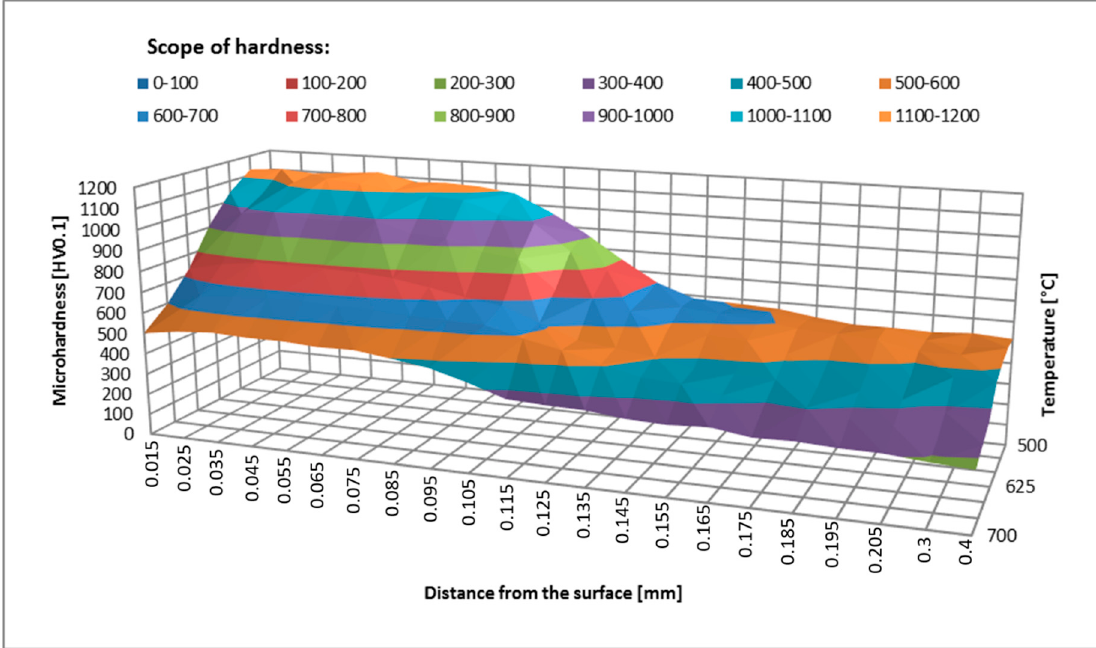
Figure 4. Hardness in the surface layer of samples after annealing for 4 h as a function of the distance from the surface.